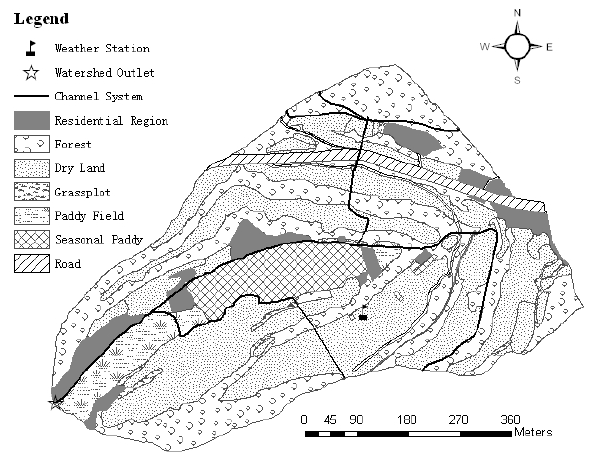
Fig. 1. Land use, channel system, and monitoring locations in the Yanting